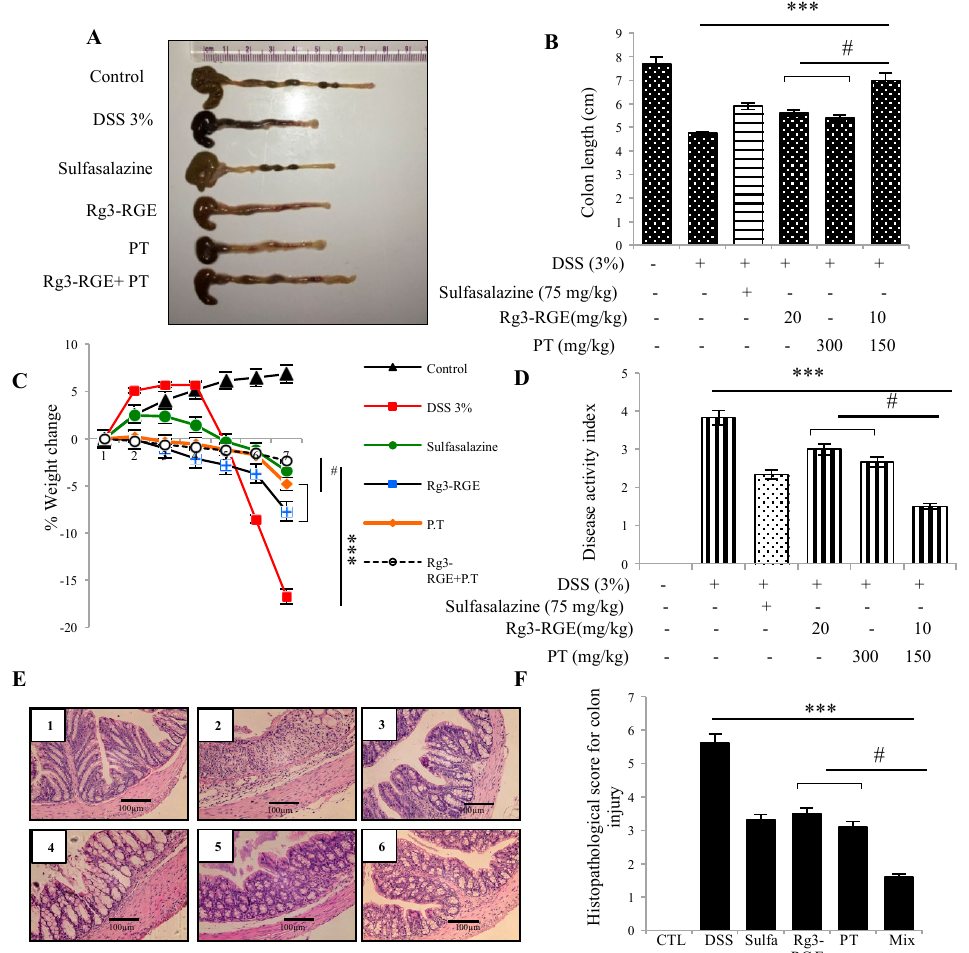
Figure 5. Improvement of colon length, disease activity index (DAI) and histopathological lesions by Rg3-RGE + PT treatment. C57BL / 6 mice were given 3% DSS in drinking water for 7 days along with p.o. treatment of the extracts. After 7 days, mice were euthanized, and the colon tissue were extracted for macroscopic and microscopic lesion assessment. ( A ) Gross examination of colon length ( B ) Quantification of colon length. ( C ) % Change in the body weight of mice. ( D ) DAI. ( E ) Hematoxylin and Eosin (H&E) staining of colon tissues (1) Control, (2) DSS, (3) Sulfasalazine + DSS, (4) Rg3-RGE + DSS, (5) PT + DSS and (6) Rg3-RGE + PT + DSS. Scale bar = 100 µ m. ( F ) Histopathological score for colon damage. *** p < 0.001 considered significant compared to DSS group and # p < 0.01 compared to inhibition by only Rg3-RGE or PT. Macroscopic analysis were conducted the same day of